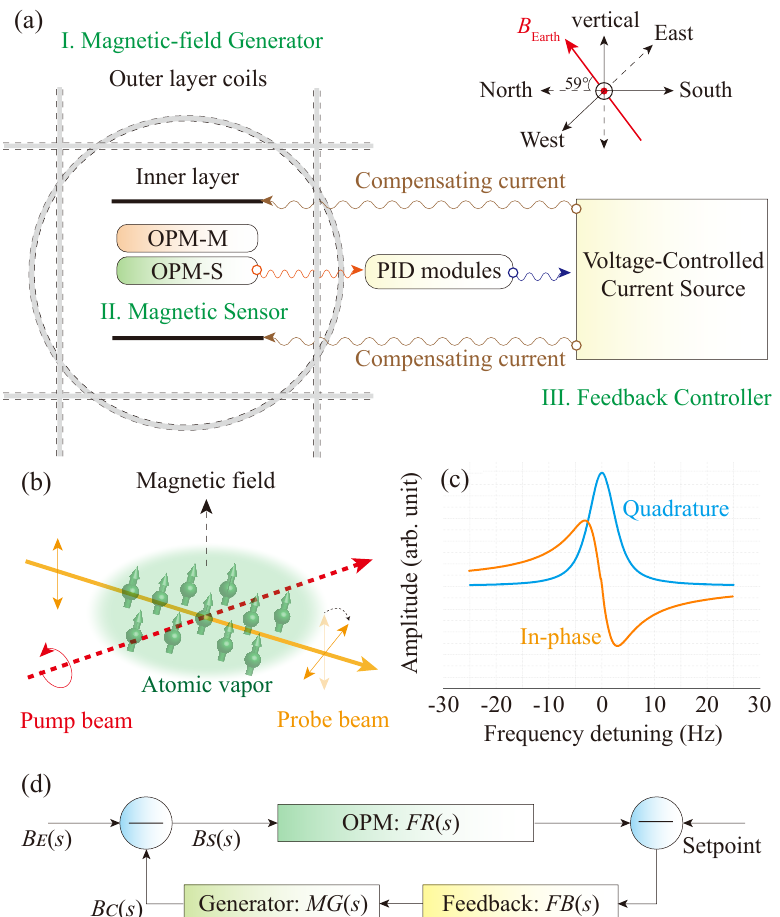
Figure 1. Active magnetic-field stabilization using optically-pumped atomic magnetometers (OPMs). ( a ) Schematics of the active magnetic-field stabilization system. The OPMs are placed in the center of two sets of Helmholtz coils. The readout from the bottom OPM sensor, OPM-S, is used as an input signal for the feedback controller (the PID modules and the voltage-controlled current source), which drives the inner layer of coils to compensate for the magnetic-field fluctuations. ( b ) Schematics of the OPM sensors. The Cs vapor cell is kept at room temperature. A circularly-polarized pump beam is amplitude modulated to synchronize the Larmor precession of the atomic spins. The optical rotation of a linearly-polarized probe beam is used to monitor the Larmor precession of the atomic spins. ( c ) A typical magnetic resonance signal of our OPM sensor in a 20,000 nT bias field. ( d ) The block diagram of the magnetic-field stabilization system. B E ( s ) : the environmental magnetic-field variation in the Laplace domain, B C ( s ) : the magnetic field produced by the inner layer of coils to actively compensate for the magnetic-field variation, B S ( s ) : the noise-suppressed magnetic field and is equal to B E ( s ) − B C ( s ) , FR ( s ) : the transfer function of the bottom OPM sensor, Setpoint: the target magnetic field to be stabilized to and is unchanged during the experiment, FB ( s ) : the transfer function of the feedback controller, MG ( s ) : the transfer function of the magnetic-field generator, or the inner layer of